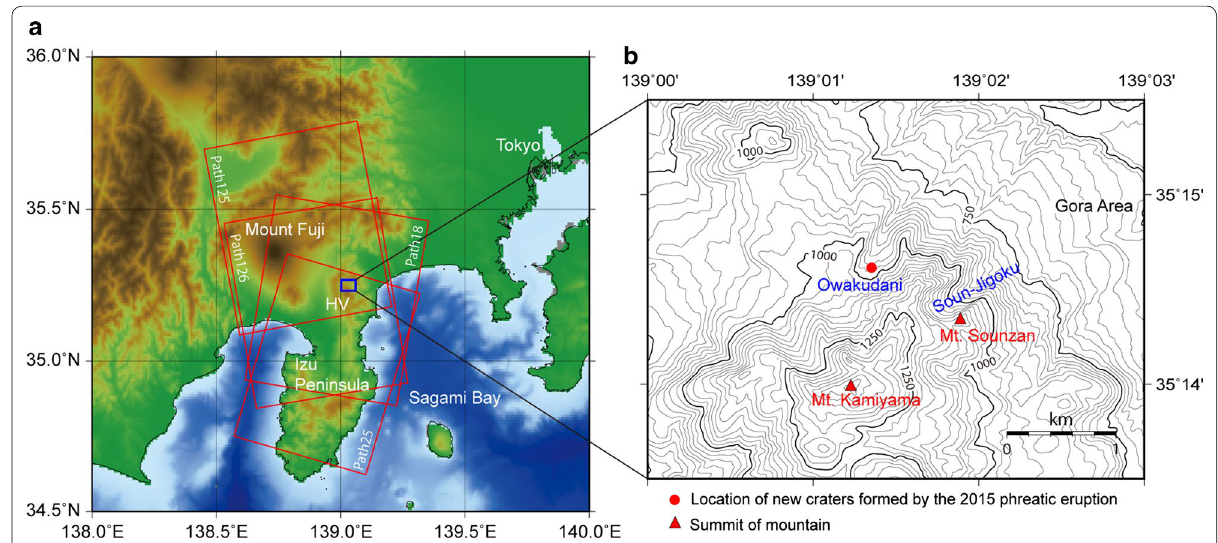
Fig. 1 Location maps of Hakone Volcano. a The map shows the area around Hakone Volcano. The color map was made from the 50-m mesh height data released by the Geospatial Information Authority of Japan (GSI) and the 500-m mesh depth data of the Hydrographic and Oceanographic Department of the Japan Coast Guard. HV: Hakone Volcano. b The map shows the area of focus, which is the north side of the central cone of Hakone Volcano. Twenty-five-meter contour lines extracted from 10-m mesh height data released by the